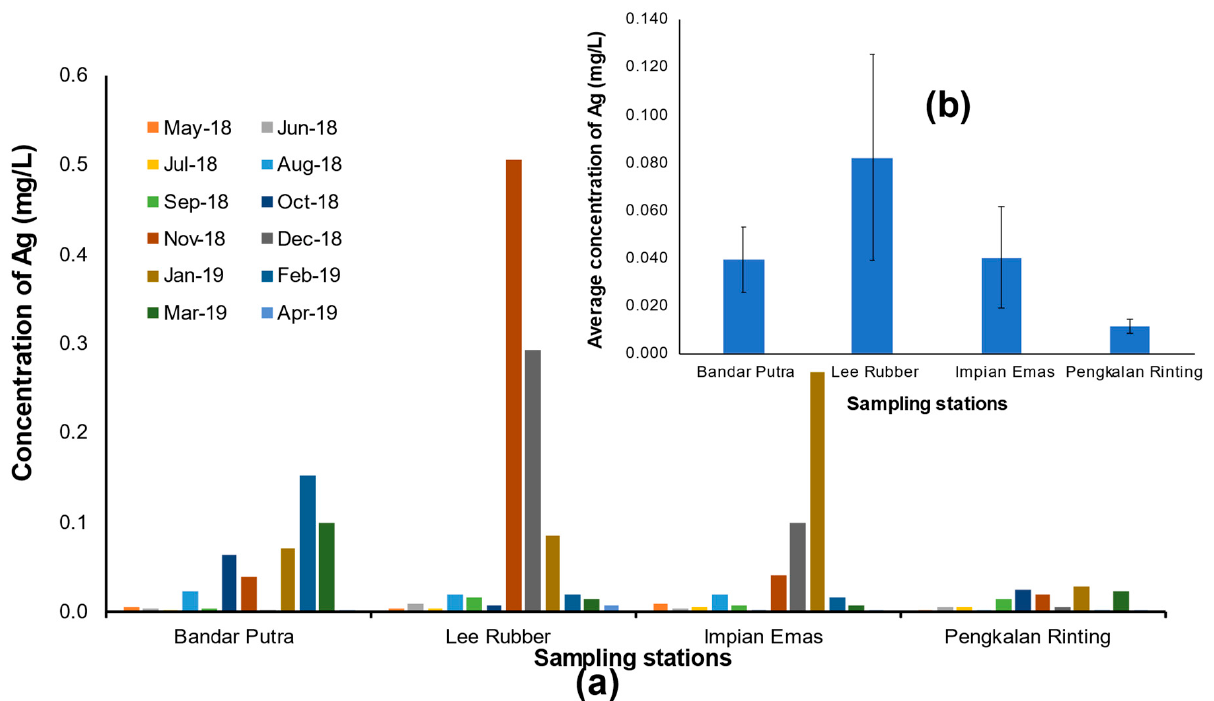
Figure 2. ( a ) Monthly concentration of Ag over a one-year period and ( b ) average concentration of Ag in Skudai River water samples by sampling stations.